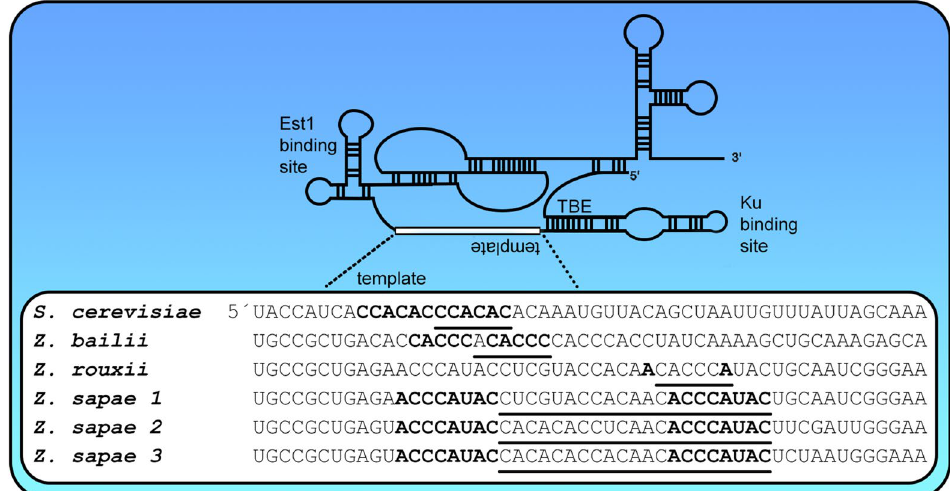
Figure 3. Schematic picture of telomerase RNA and template regions in Saccharomyces cerevisiae , Zygosaccharomyces bailii , Z. rouxii , and Z. sapae . We identified the same putative consensus telomere sequence as 5 ′ -ACA CCC (or its permutations) in Saccharomyces cerevisiae , Zygosaccharomyces bailii and Z. rouxii , although the template regions, annealing and telomere synthesis during reverse transcription differed in all three species. The corresponding template regions are indicated in bold in the sequences (direct repeats), and underlined fonts (template sequence), respectively. (1) In S. cerevisiae the maximum template region consists of two adjacent CCA CAC repeats. (2) In Z. bailii the template region is formed by a shorter sequence than